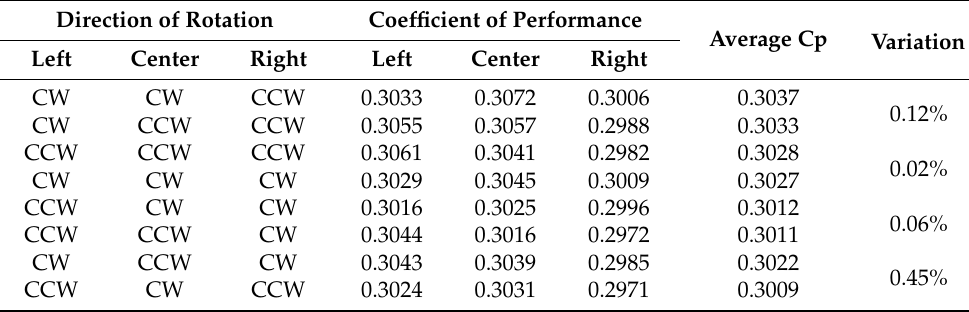
Table 7. Power coefficient with varying rotational directions. Direction of Rotation Coefficient of Performance